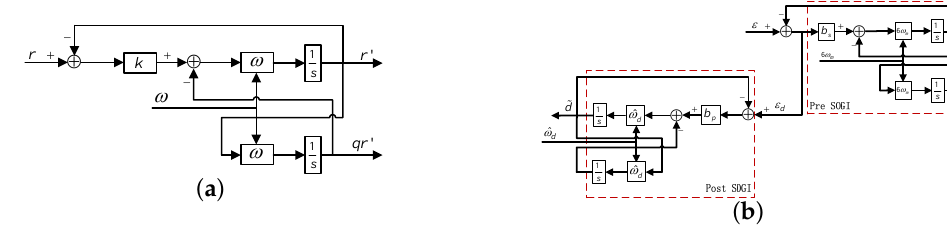
Figure 14. Block diagram of SOGI. ( a ) general SOGI; ( b ) pre and post SOGI.